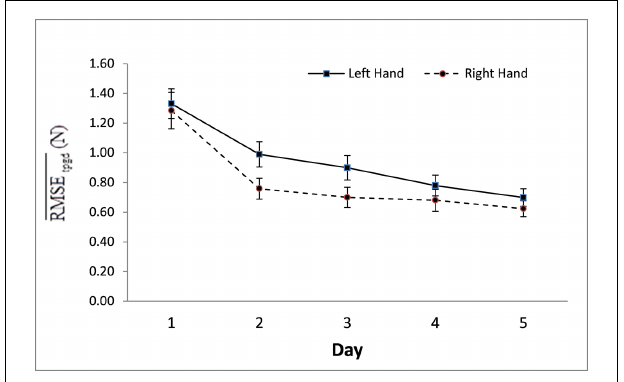
FIGURE 2 | Mean RMSE and standard errors of right and left hand performances by practice day as averaged over all segments (s) of all respective performance hand trials (t) of all participants (p) of all age groups (g). The mean RMSE scores of right vs. left hand performance were significantly different on Days 2 and 3 ( p <